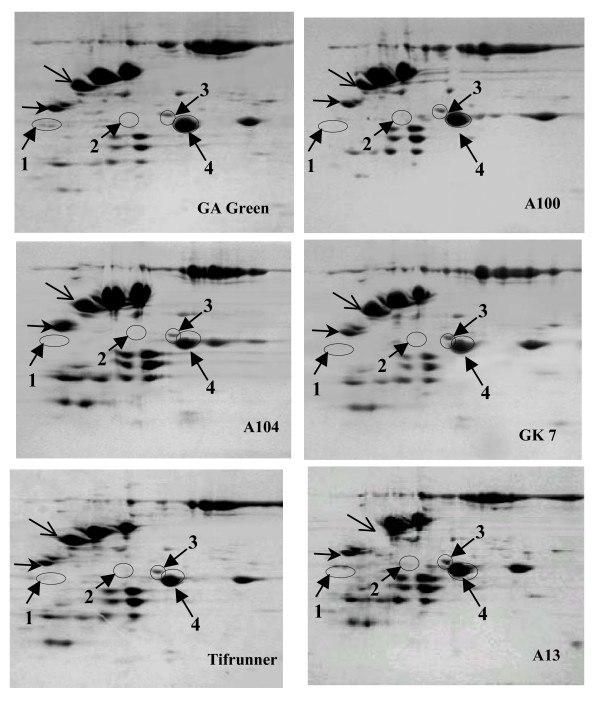
2-D SDS-PAGE peanut seed total protein profiles. Two-dimensional SDS-PAGE of peanut seed total protein profiles of 6 cultivated peanut genotypes, runner market type. Gels are oriented with the acid end of the isoelectric focusing separating to left and the basic end to the right (Fig. 2). The arrow () indicates the protein band with a molecular weight of 35 kDa and the arrow () indicates the 27 kDa protein band (Fig. 1). The numbered arrows () pointing to cycled spots indicate the polymorphic polypeptide spots, which were sequenced (Table 2).